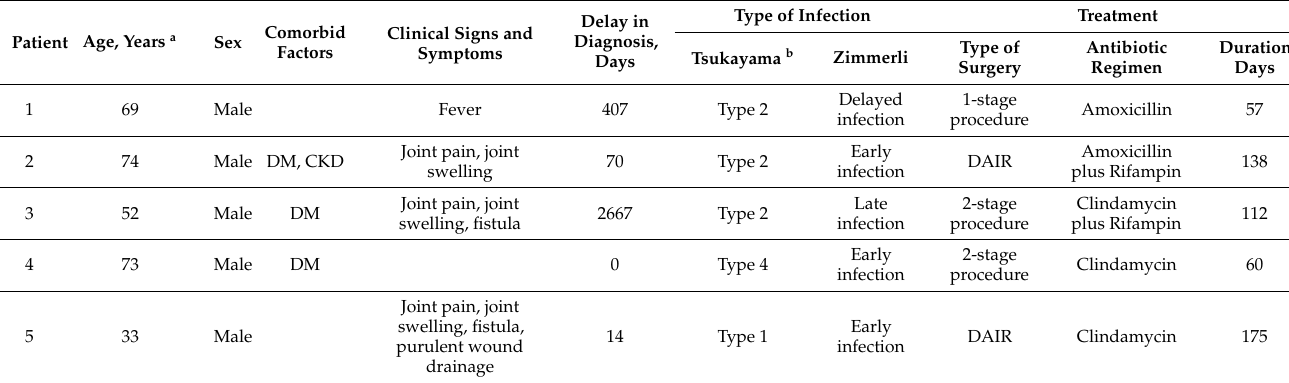
Table 5. Individual clinical characteristics and treatment of the five recurrence